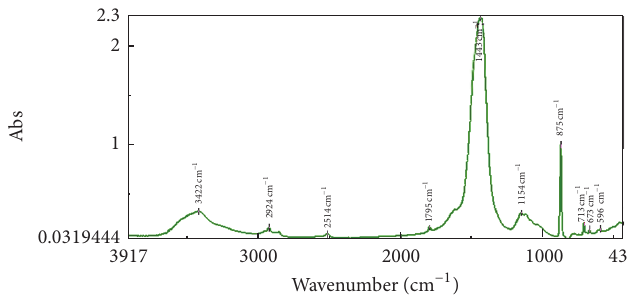
Figure 2: FTIR spectrum of the Imperial Gate (IG) rear background.